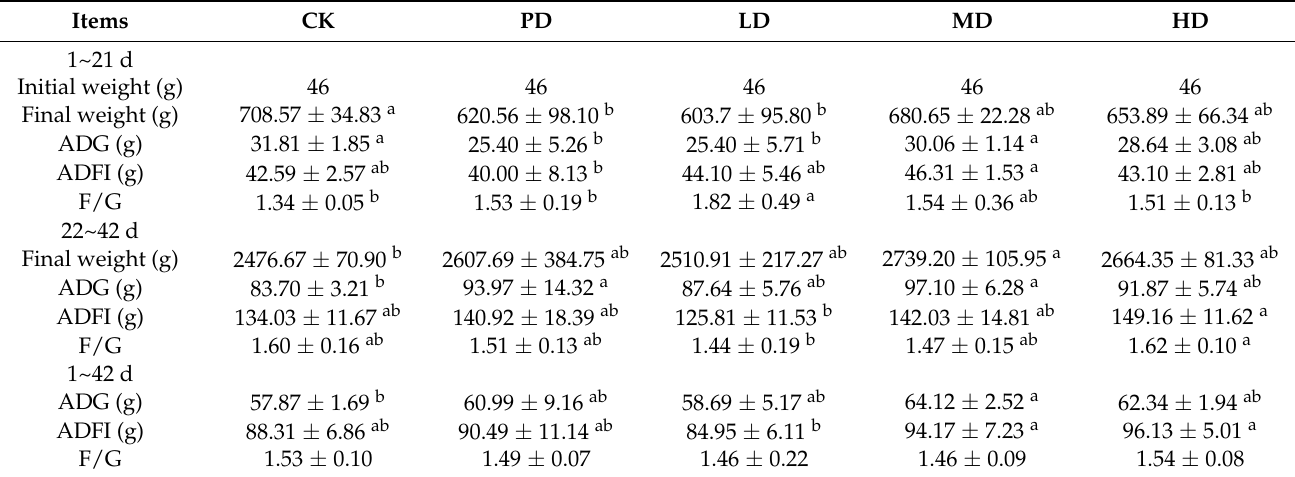
Table 3. Effects of the fruit extract of K. coccinea on growth performance of white-feather broilers (n =